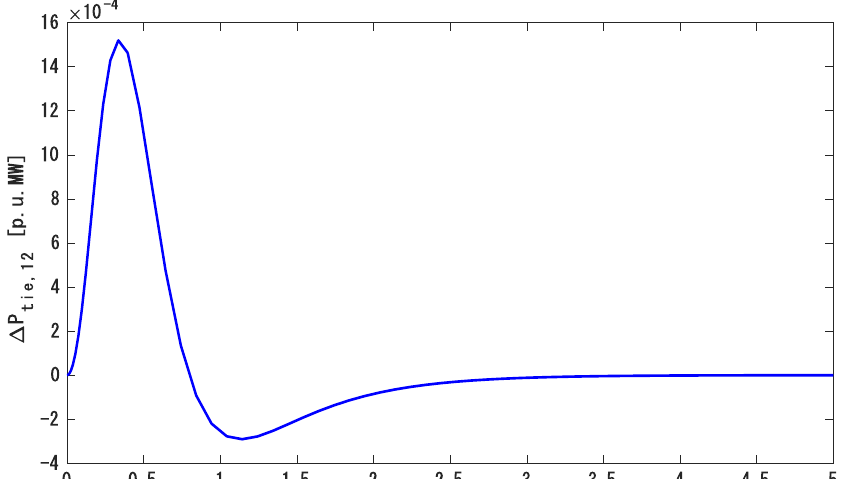
Energies 2021 , 14 , x FOR PEER REVIEW Figure 2. The frequency variation. Figure 2. The frequency variation.